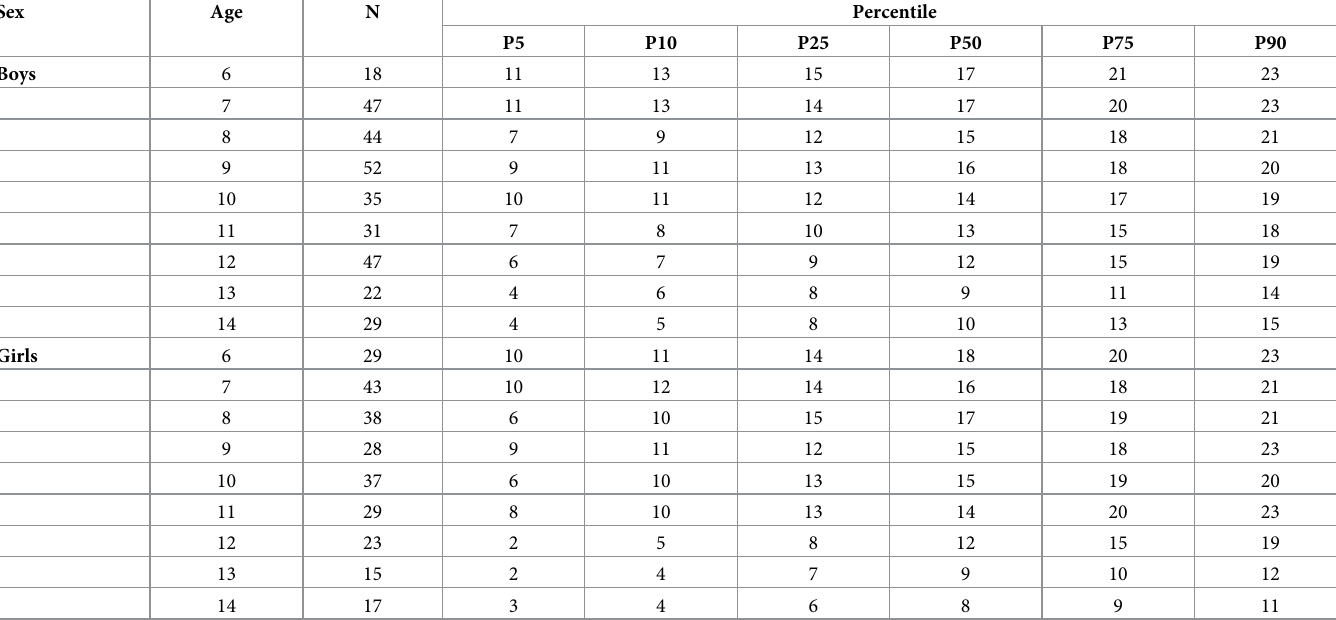
Table 2. Normative values for relative schoolbag weight (%) of the study participants, Czech